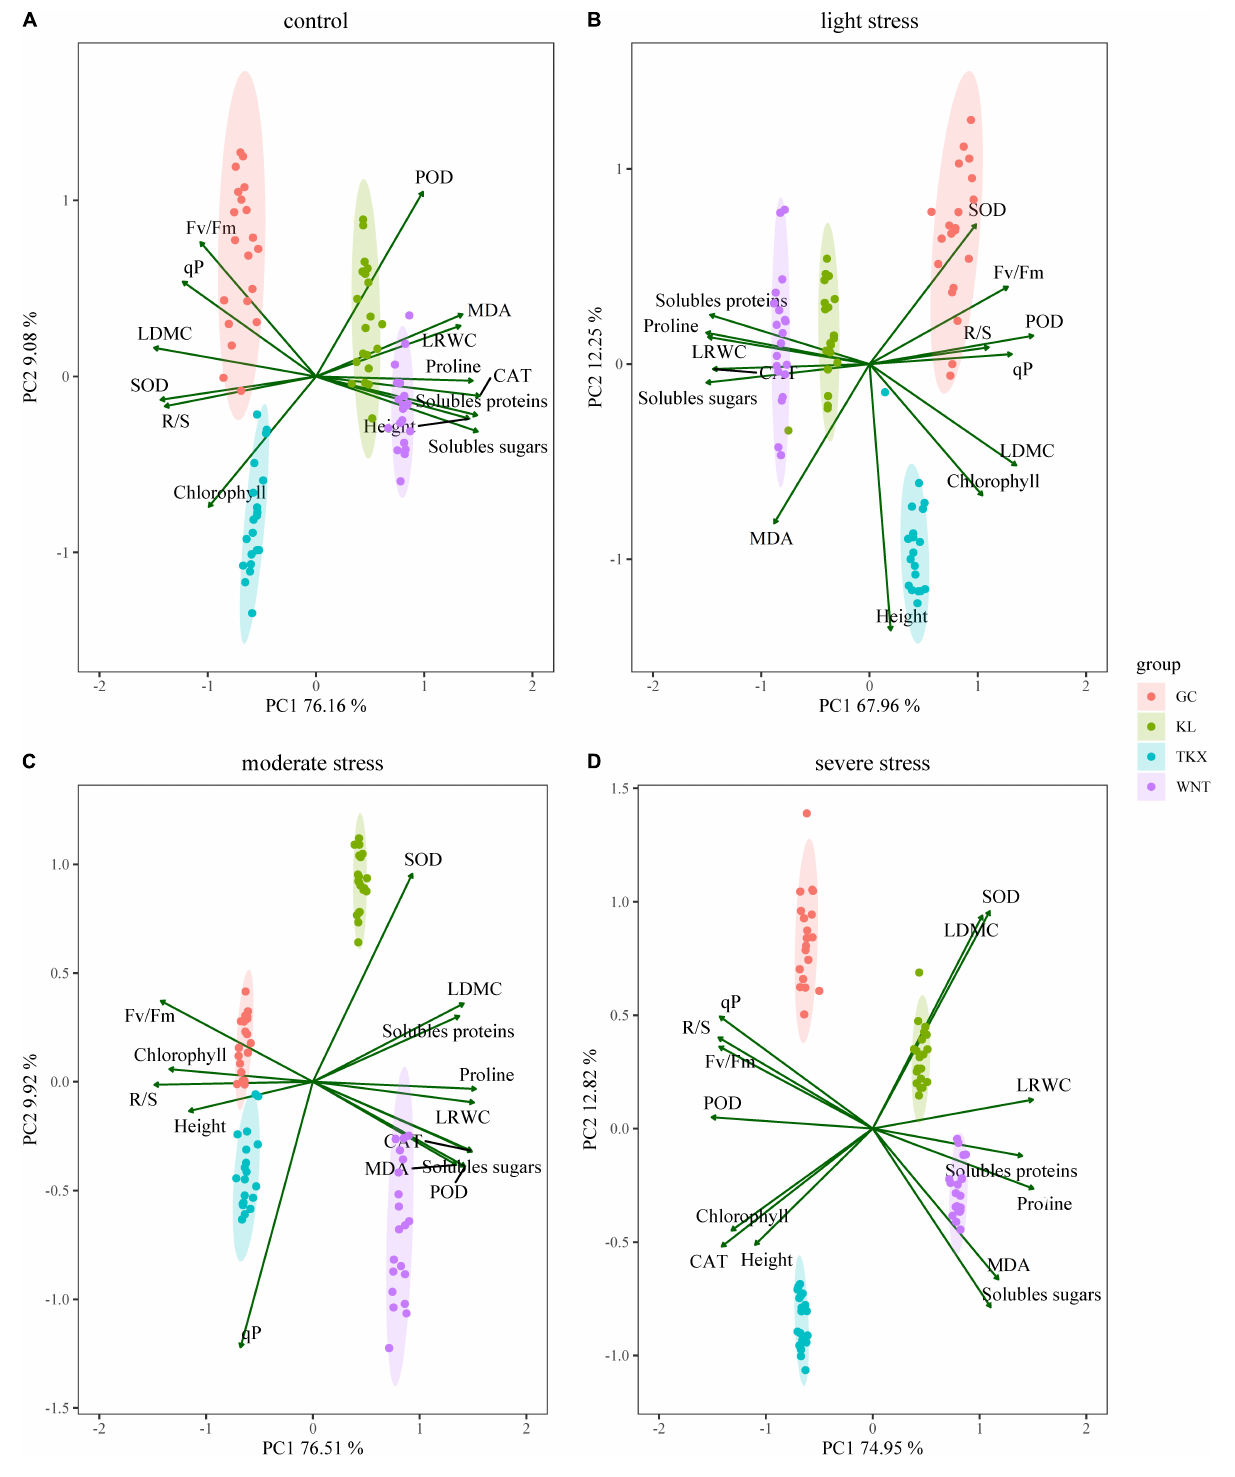
Frontiers in Plant Science |